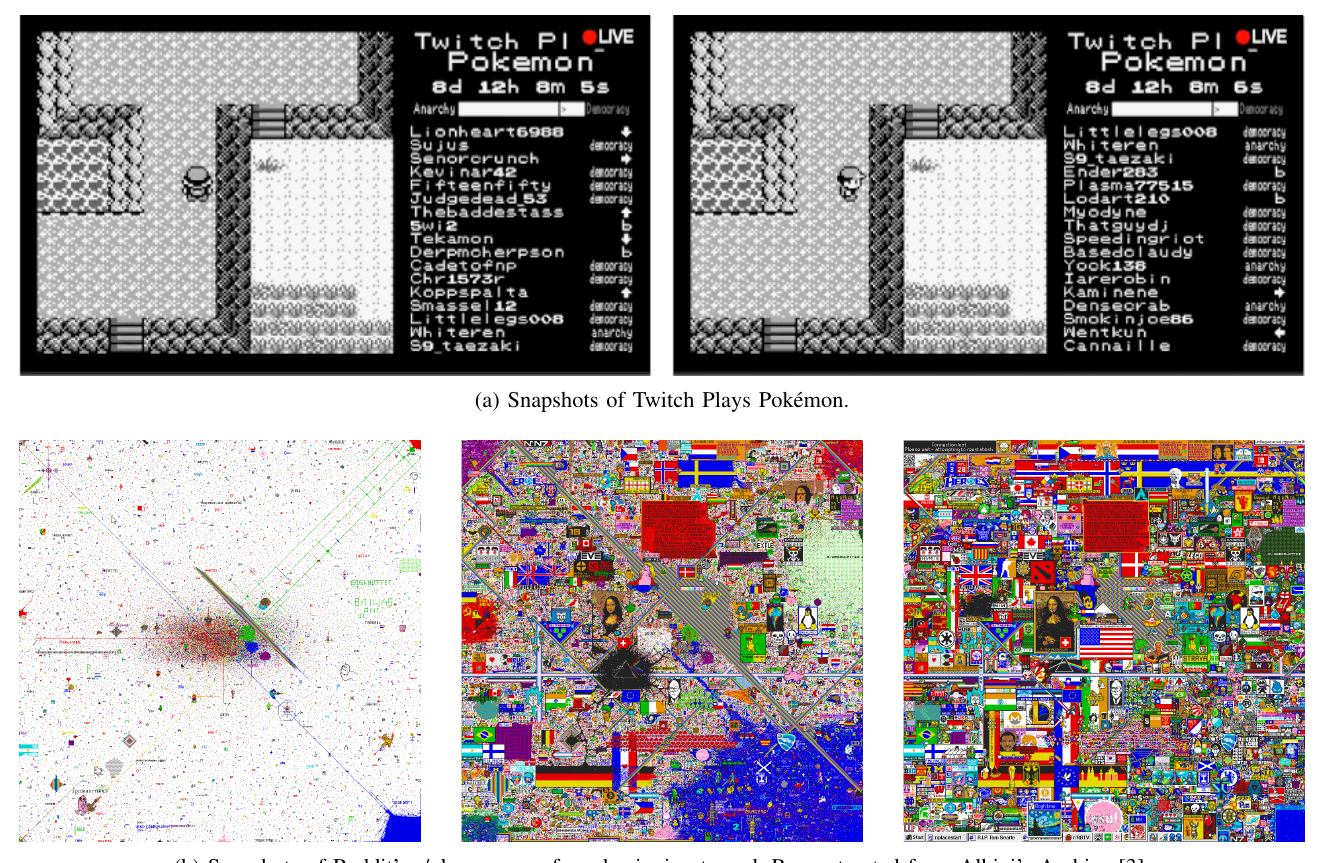
Figure 4: Social dialogue genre